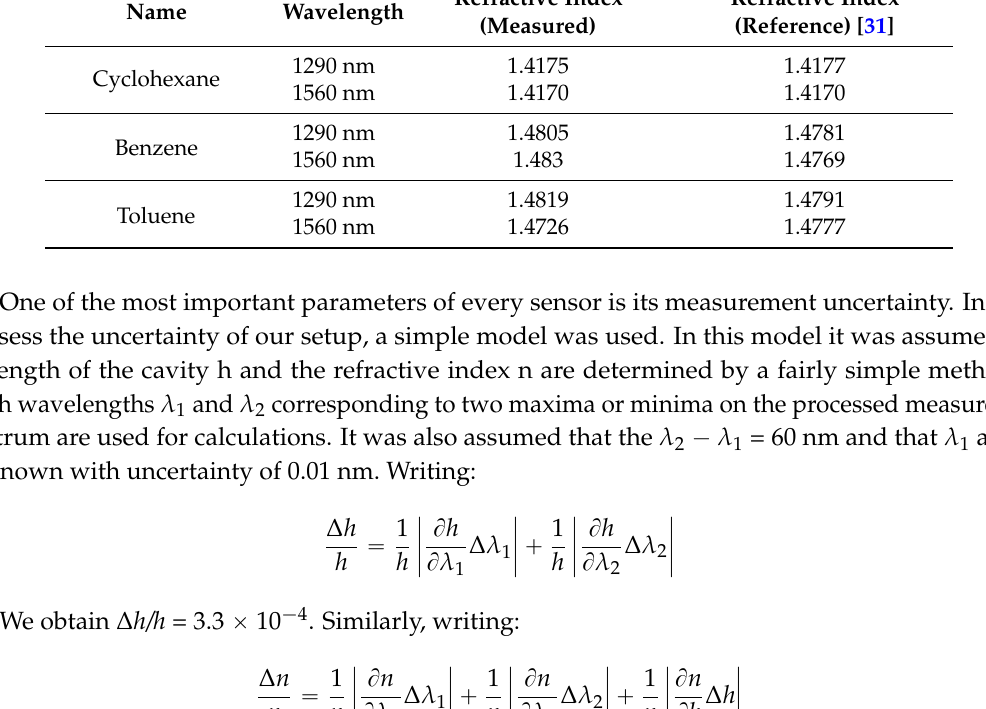
Table 1. Representative measured and reference values of the refractive index for investigated substances. Name